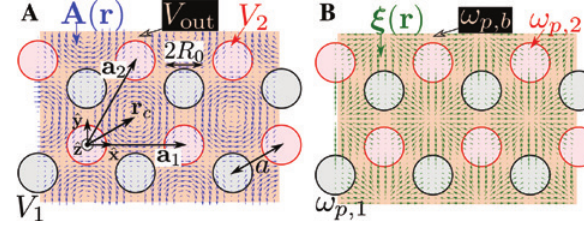
Figure 1: Geometry of the